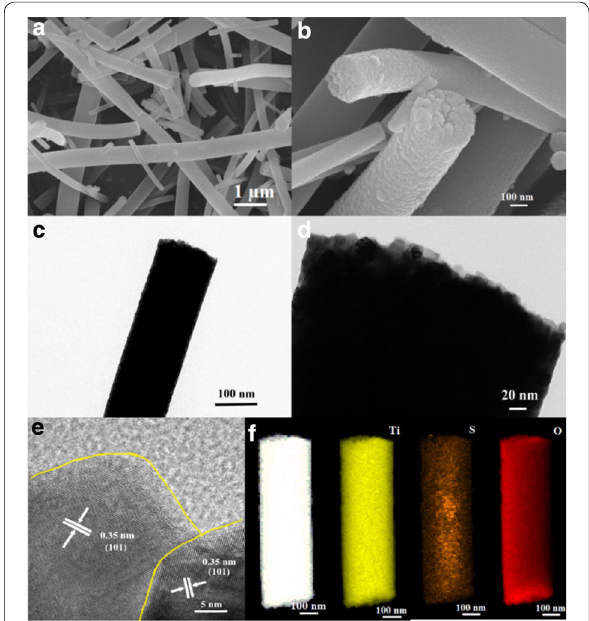
Figure 3 SEM images of the TiO 2 /S composite nanofibers: a lower magnification, b higher magnification, c TEM images of the TiO 2 nanofibers, d TEM images of the TiO 2 /S nanofibers, e HRTEM image of the ( c ), f corresponding EDS mapping for elemental titanium, oxygen and